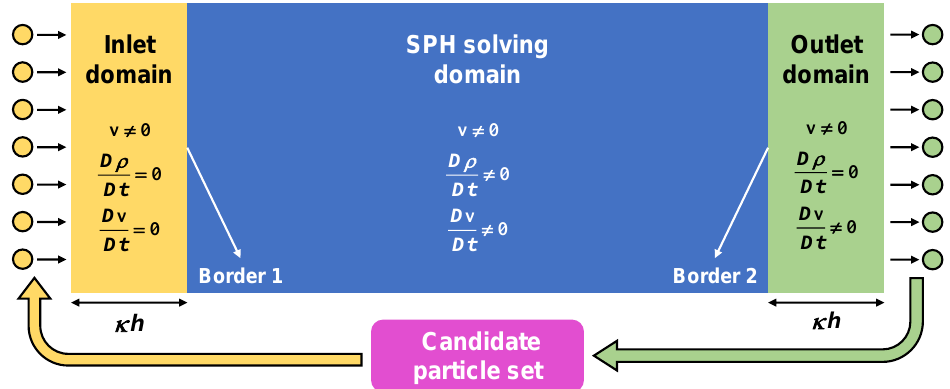
Figure 8. The schematic diagram of inlet/outlet boundary conditions implemented in particle-based methods (e.g.,